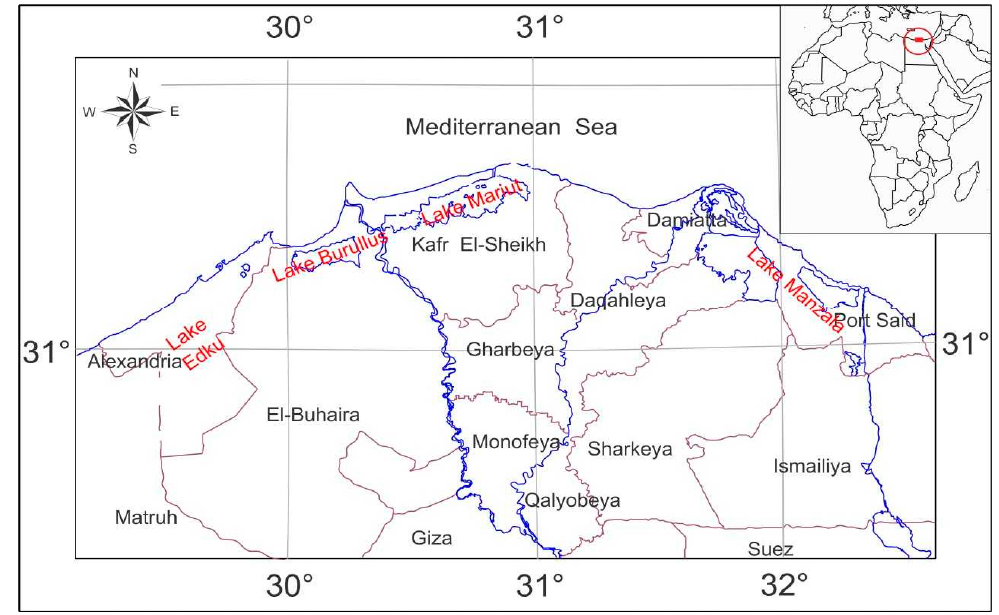
Figure 1. The study area of the Nile Delta.